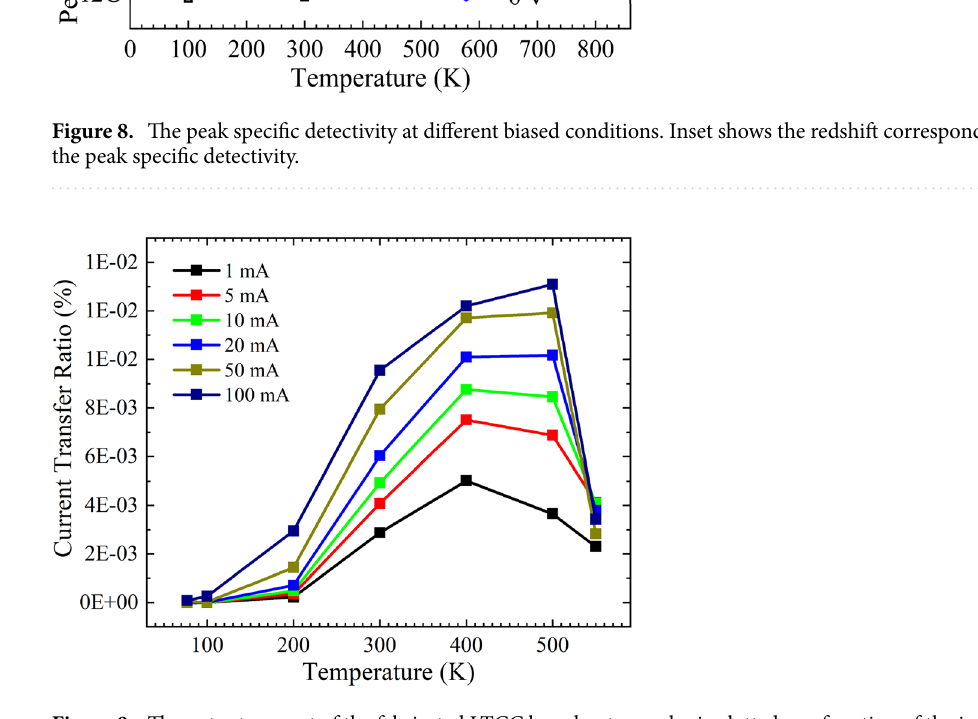
Figure 9. The output current of the fabricated LTCC based optocoupler is plotted as a function of the input current for different